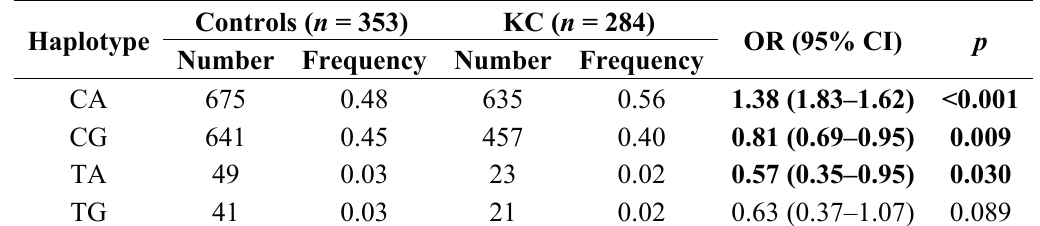
Table 3. Distribution of haplotypes of the c.580C>T and c.1196A>G polymorphisms of the XRCC1 gene and OR with 95% CI in patients with KC and